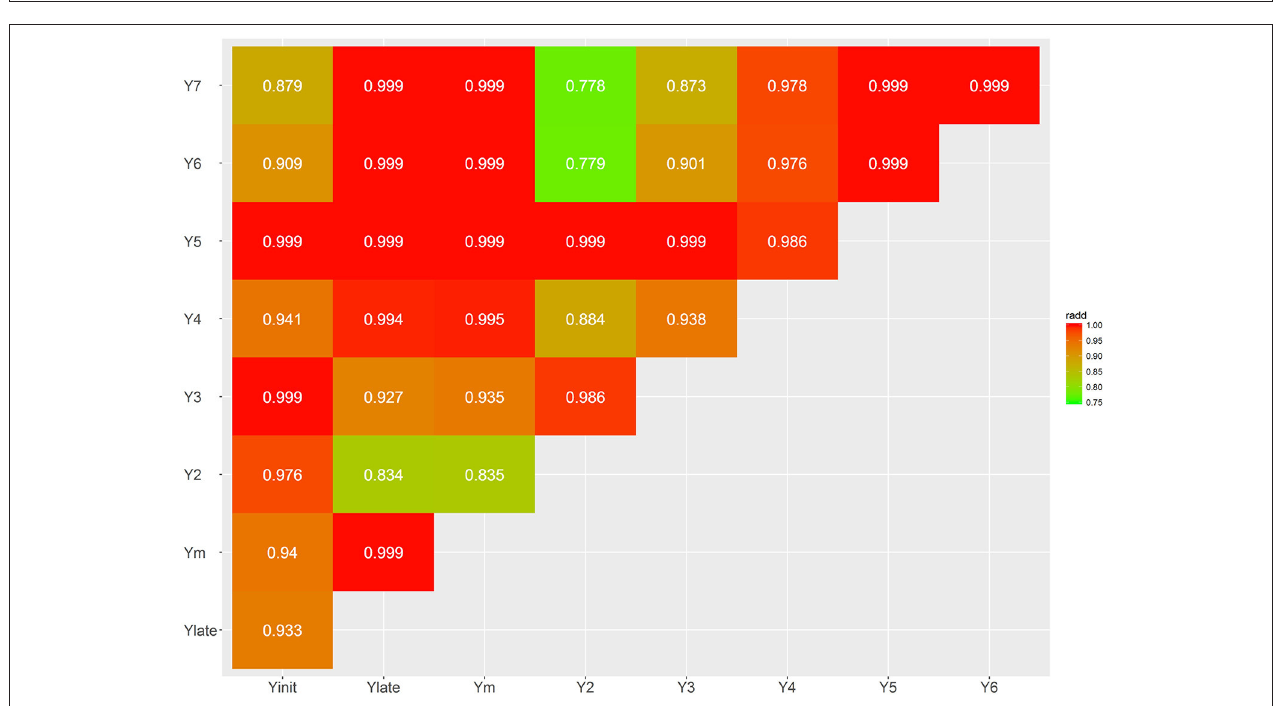
FIGURE 4 | Genetic trait correlations for additive effects: all yield derived traits.